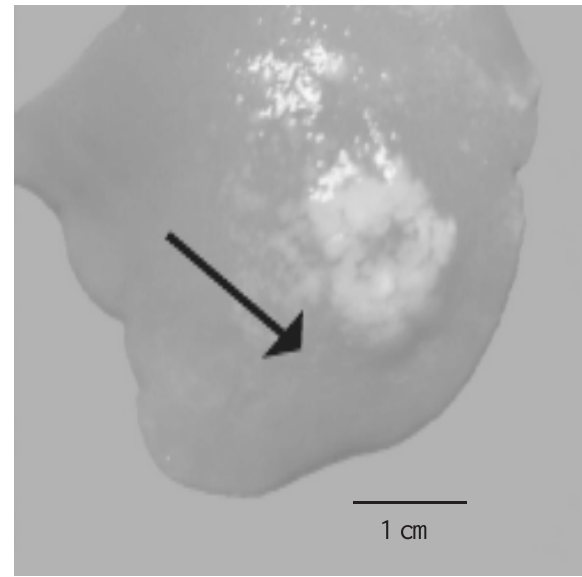
Figura 1 – Aspecto macroscópico do fígado de coelho portador do tumor VX-2, decorridos 7 dias da infiltração de suspensão de células tumorais.